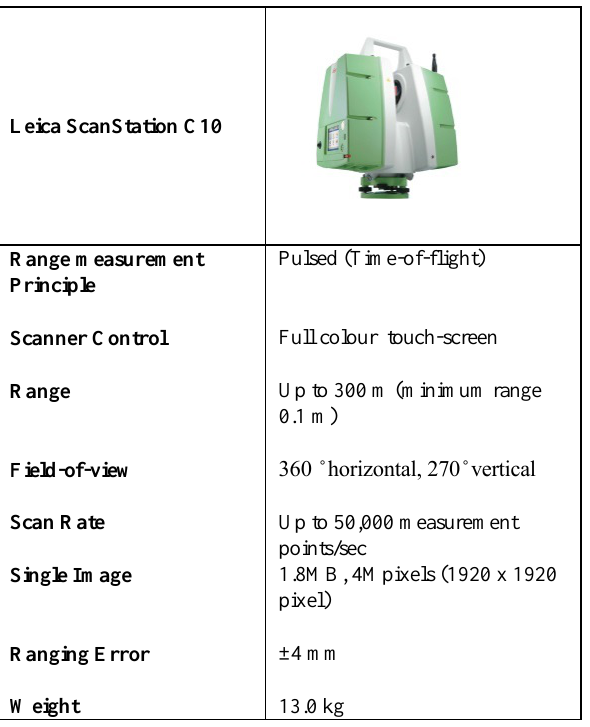
Table1. Specification Leica ScanStation